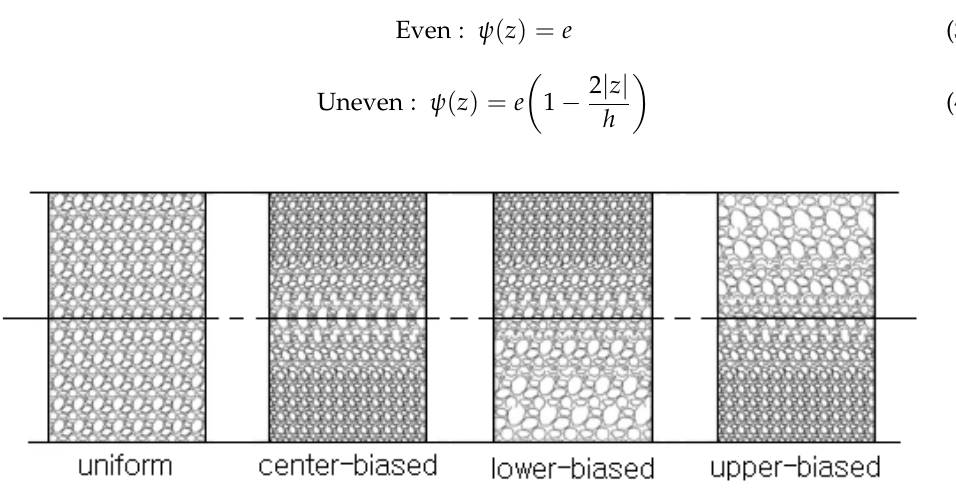
uneven or sym, and lower- and upper-biased distributions are called unsym-1 and unsym-2, respectively. First, the porosity ψ ( z ) in even and uneven distributions is expressed by